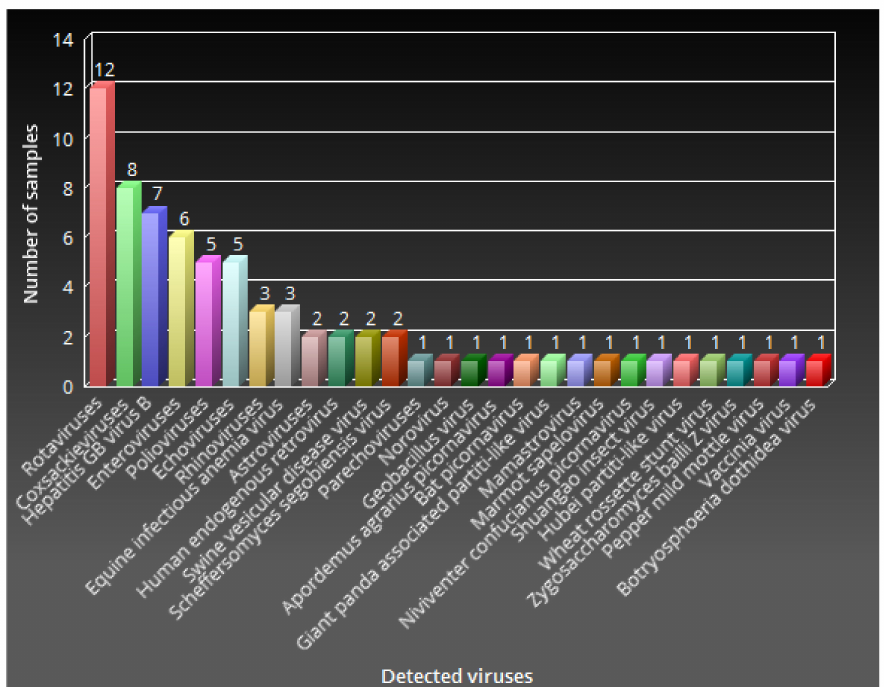
Figure 1. Detection rate of each virus among the twelve faecal samples. Only four di ff erent virus genera / species were present in at least half of the samples, with rotavirus being the only genus detected in all twelve samples. The majority of the viruses were present in three or fewer